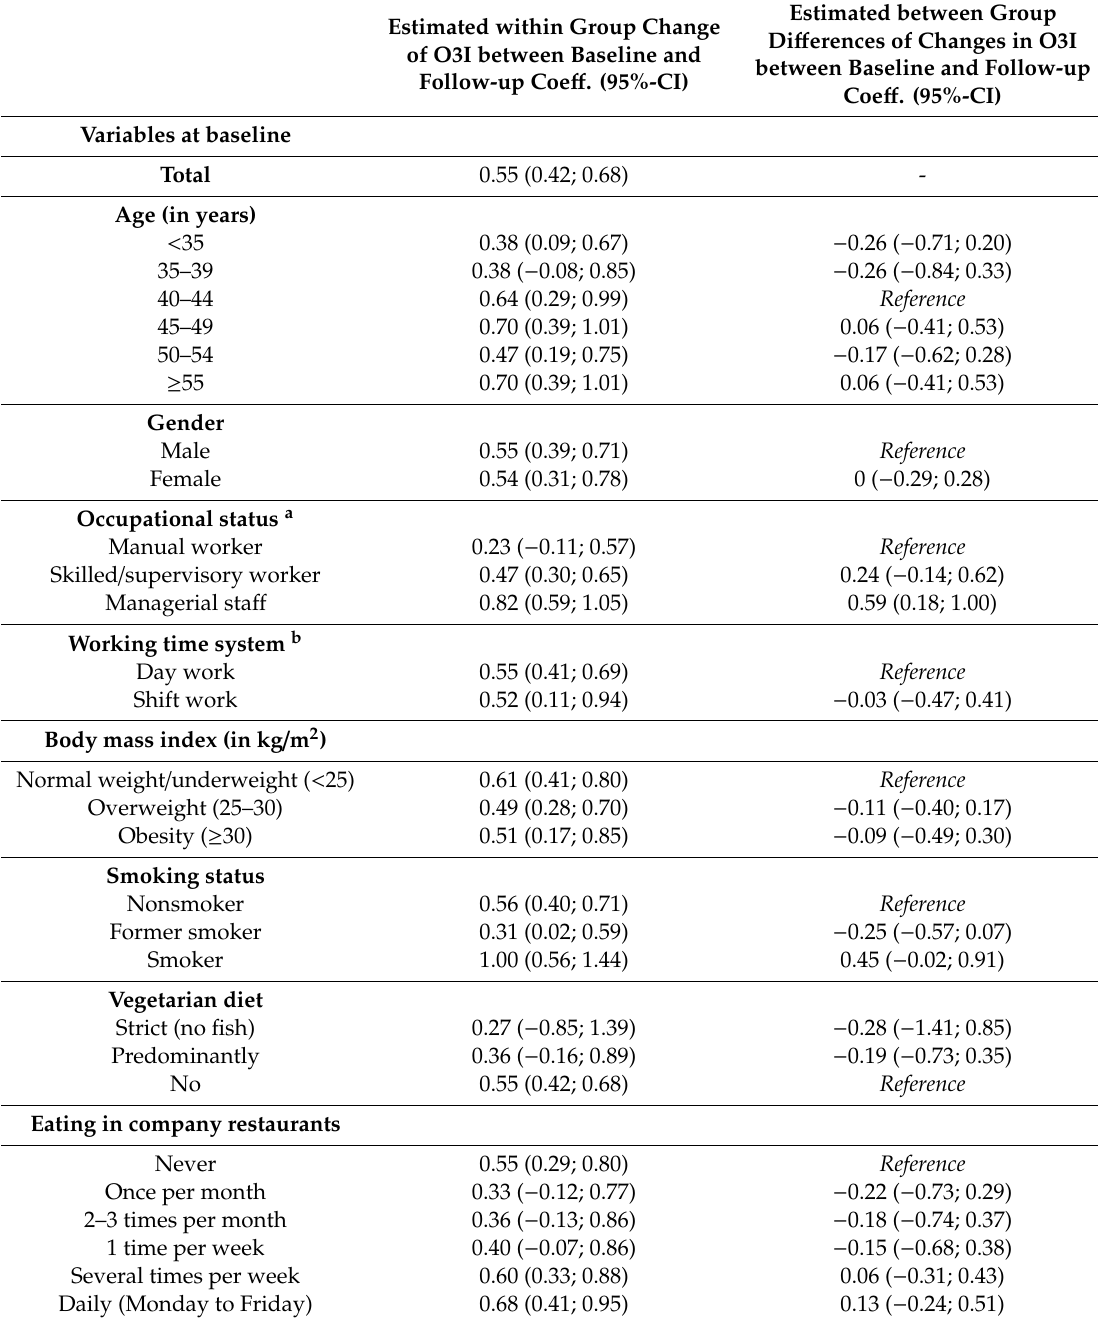
Table 5. Omega-3 index changes between baseline and follow-up within and between selected sociodemographic and occupation-related groups using linear mixed